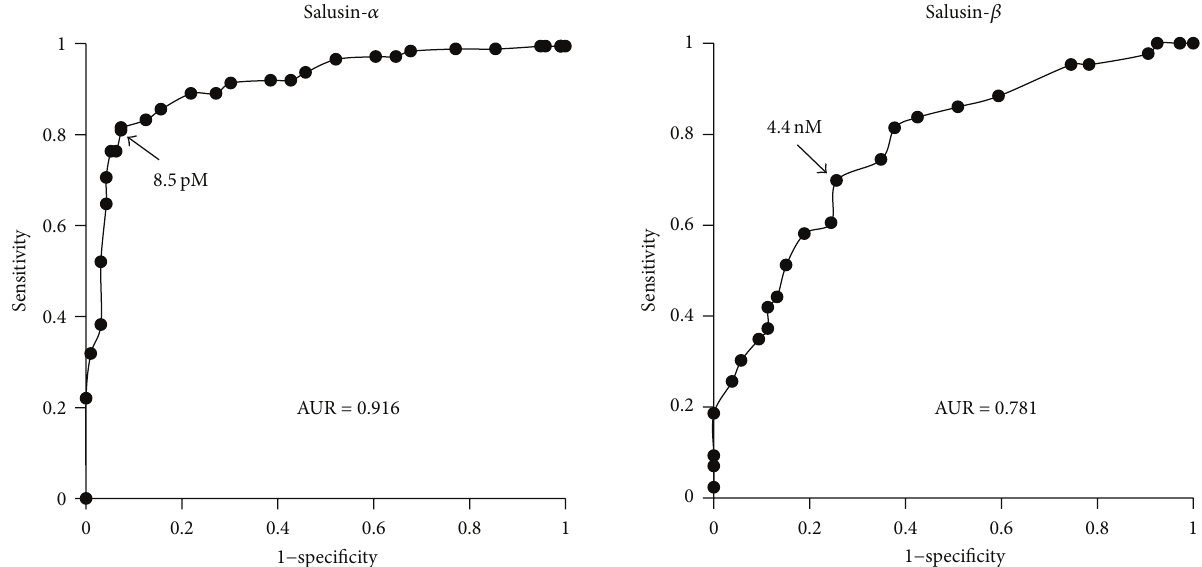
Figure 4: ROC curves of salusin- 𝛼 and salusin- 𝛽 for detecting